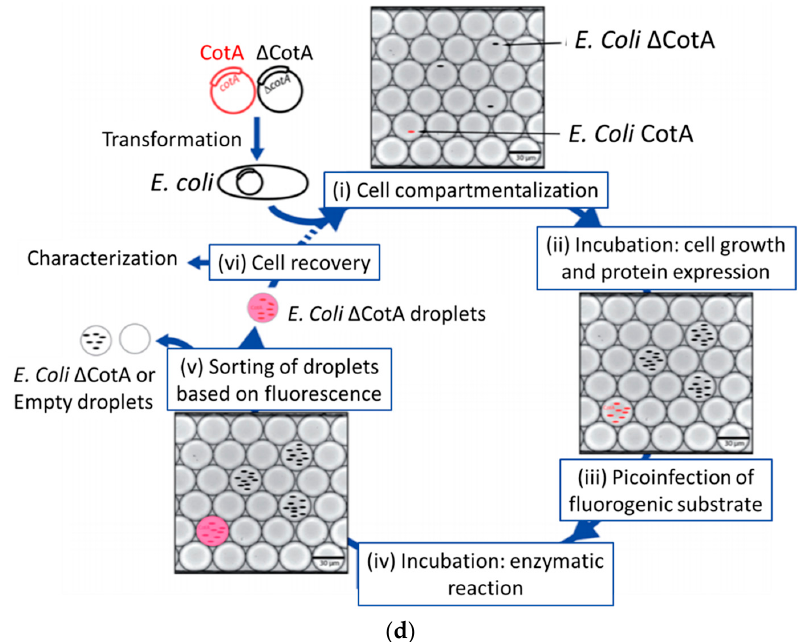
Figure 4. Droplet-based microfluidics for proteomics. ( a ) Separating the stages of nucleation and growth in the crystallization of “severe acute respiratory syndrome (SARS) protein” yields single crystals, reproduced with permission from [62] , published by John Wiley and Sons, 2006. ( b ) A droplet-interfaced 2D nano liquid chromatography-capillary electrophoresis (LC-CE) system. The HPLC effluent is fractionated into a series of nanoliter droplet units right after chromatography (panel (i)), and collected and stored in a tube (panel (ii), tube inside diameter: 0.38 mm), before drop-wise analyzed in capillary electrophoresis (CE) (panel iii), reproduced with permission from [72] , published by Elsevier, 2015. ( c ) Schematic illustration of the surface enhanced raman scattering (SERS)-based microdroplet sensor for wash-free magnetic immunoassay, reproduced with permission from [77] , published by Royal Society of Chemistry, 2016. ( d ) A flexible droplet-based micro-fluidic platform that can be used for high-throughput screening of Escherichia coli cells for measuring the CotA enzymatic activity, reproduced with permission from [84] , published by Royal Society of Chemistry, 2014.